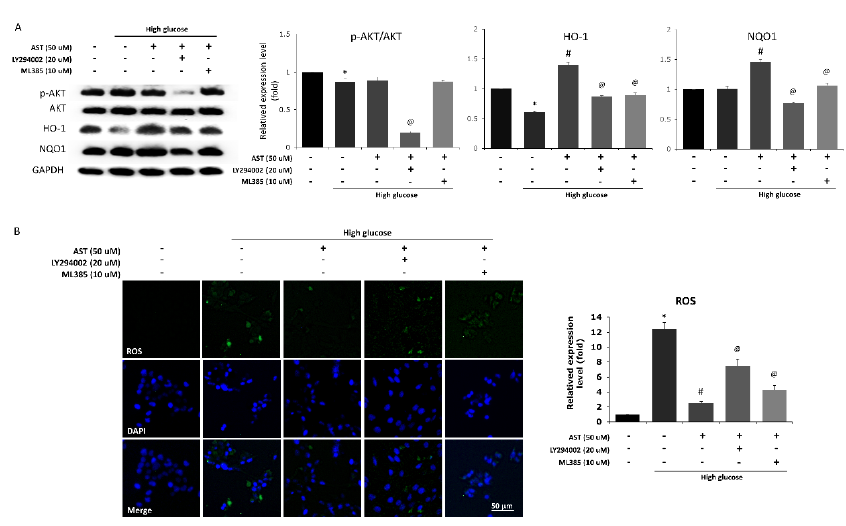
Figure 6. Blocking the PI3K/Akt/Nrf2 pathway abolishes the antioxidative effect of AST in 661W cells. Cells were administered PI3K inhibitor (LY294002, 20 μM) and Nrf2 inhibitor (ML385, 10 μM) along with AST. ( A ) The protein expression of Akt, p-Akt, HO-1, and NQO1 was detected by western blot. The PI3K inhibitor resulted in lower p-Akt/Akt ratio, HO-1, and NQO1 expression compared with AST treatment alone. Meanwhile, Nrf2 inhibition resulted in decreased expression of HO-1 and NQO1 but not the p-Akt/Akt ratio. ( B ) Both inhibitors counteracted the protective effect of AST and significantly increased the ROS levels, AST = astaxanthin; ROS = reactive oxygen species. * Significantly different from control group ( p < 0.05); # significantly different from high glucose-treated group without AST ( p < 0.05); @ significantly different from high glucose-treated group with 50 μM AST. The Mann–Whitney U test was used to calculate the differences between the means of different experimental groups (three repeats per experiment, three wells per repeat, five images per well